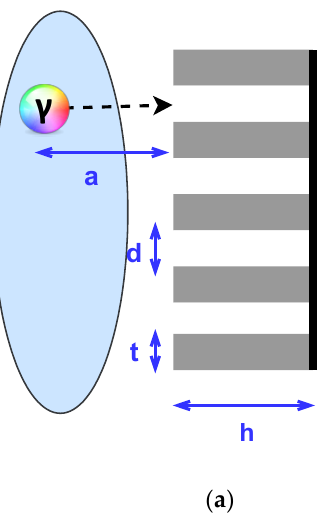
Figure 8. Schemes of two typical collimators: parallel hole ( a ) and pinhole ( b ) collimators. The ellipse in ( a ) represents the gamma-ray emitting region. P and P’ in ( b ) show how a region of the object is projected and magnified after crossing the collimator (P’ > P).